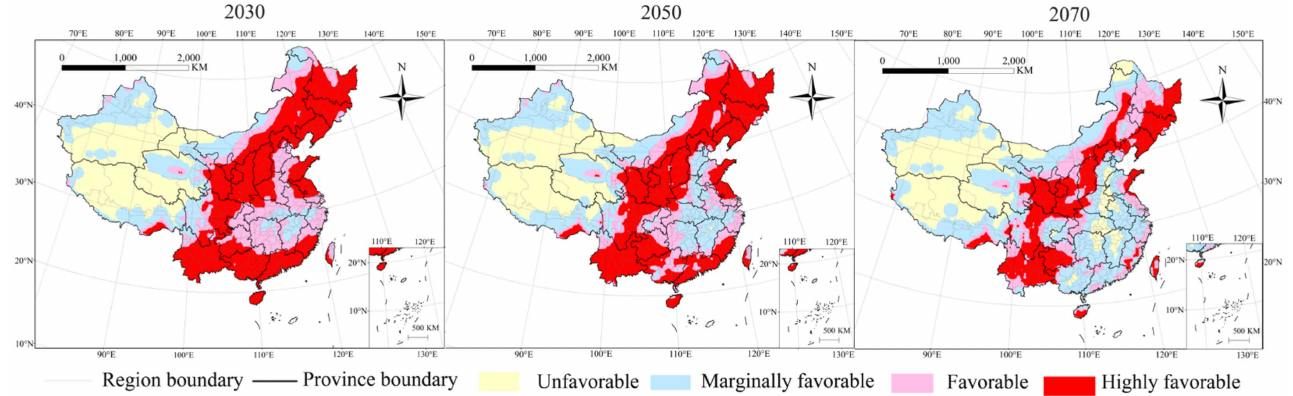
Figure 2. Potential distribution of P. interpunctella in China under future climate conditions (2030, 2050,